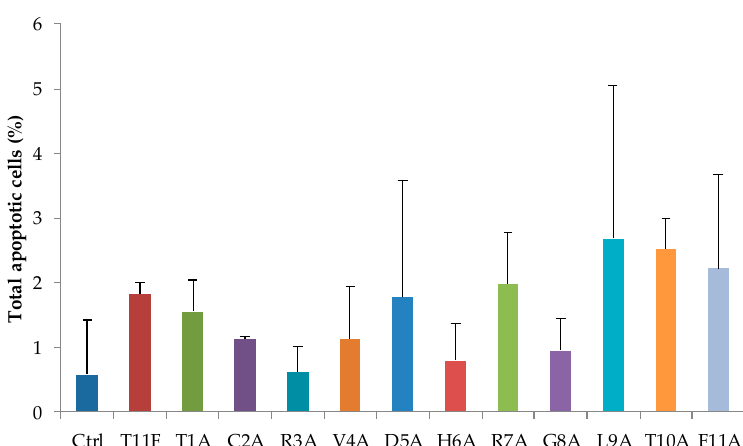
Figure 9. Lacking of apoptotic effects of T11F and its derivatives in Candida albicans SC5314 cells. Phosphatidylserine externalisation was analysed by flow cytometry, after 30 min of treatment with peptides at their EC 50 value. Data represent the mean ± standard deviation of at least three independent experiments.